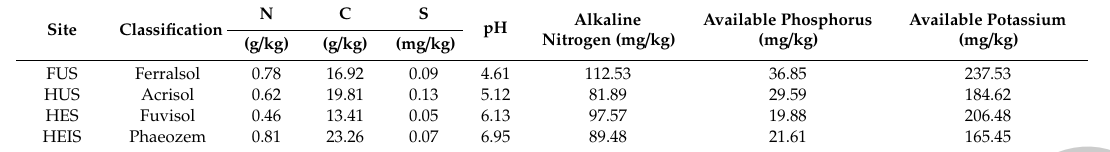
Table 1. Basic chemical properties of the four soils included in this study.